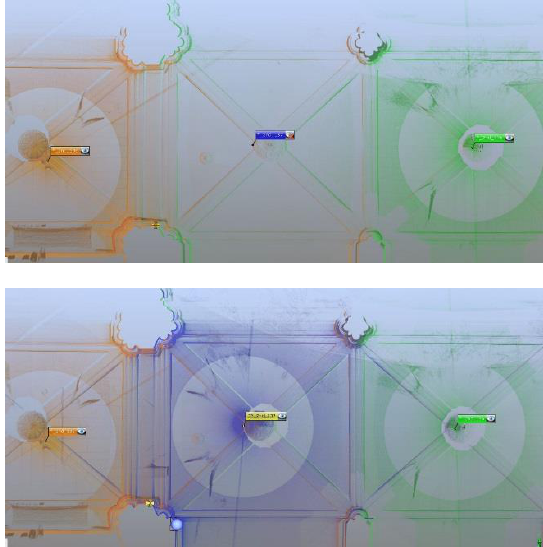
Figure 7: Screenshot of scanning data, in top view, with a scan in every second bay of the ambulatory (above) and a scan every bay (below) illustrating the need for increased scans to limit occlusions. This is particularly noticeable in the column detail (HCS,